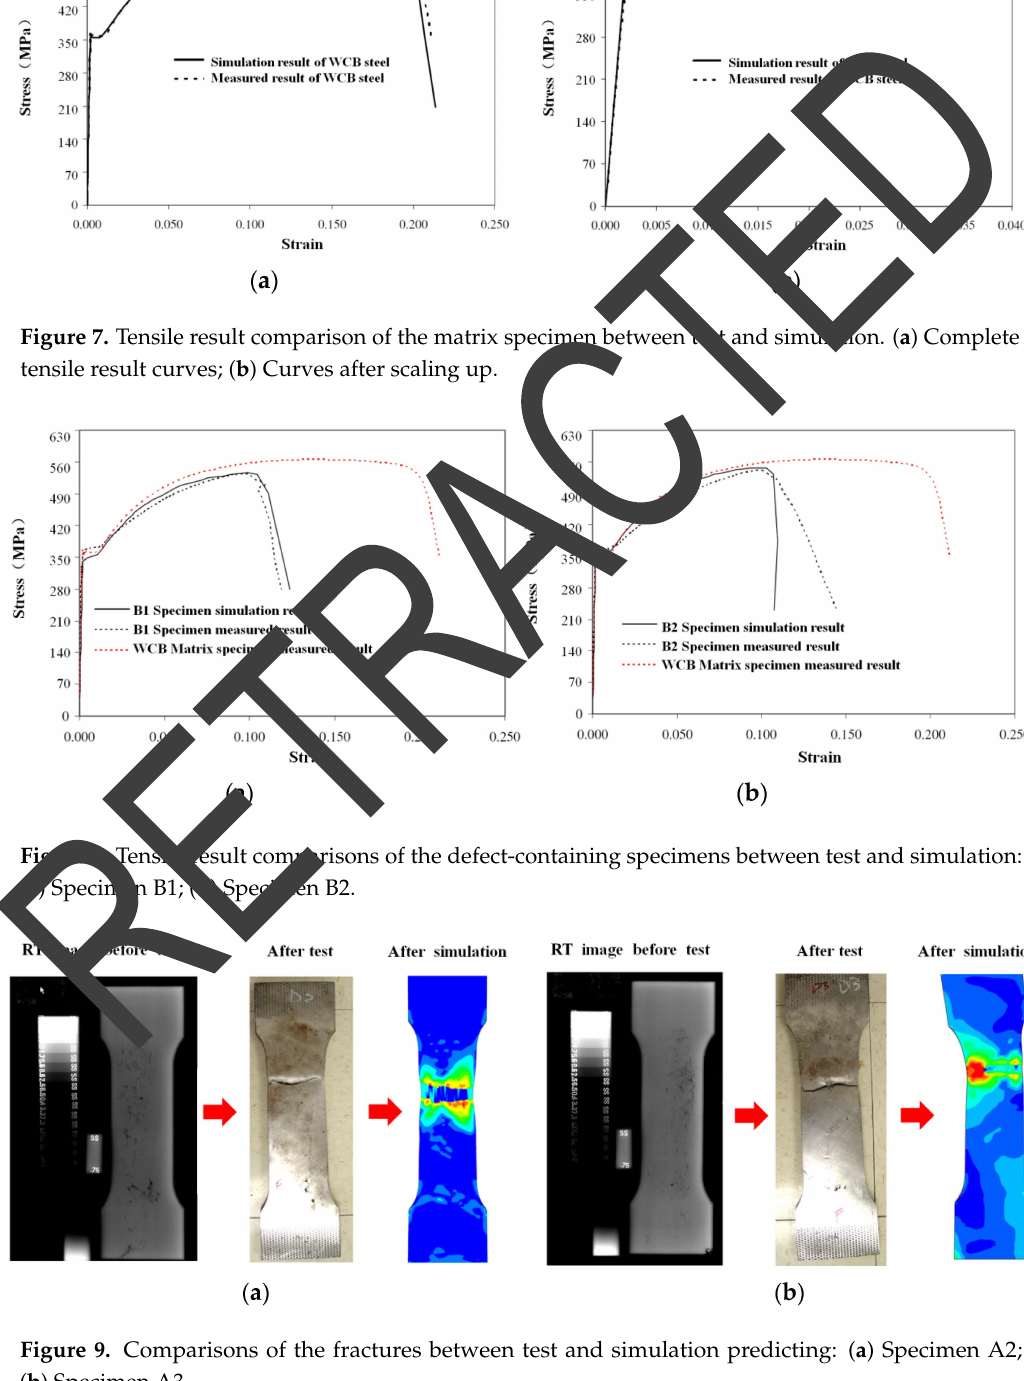
Figure 9. Comparisons of the fractures between test and simulation predicting: ( a ) Specimen A2; ( b ) Specimen